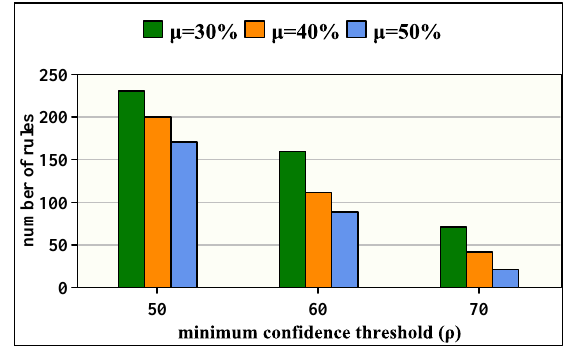
Figure 10. Variation of number of rules as a function of µ and ρ